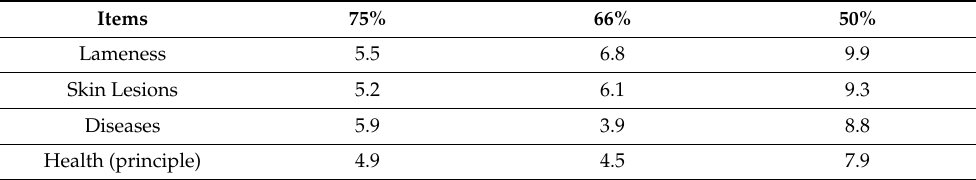
Table 5. Average deviation in % of the original score for parameters in the WQ protocol when 75%, 66% or 50% of the animals was scored individually during the clinical